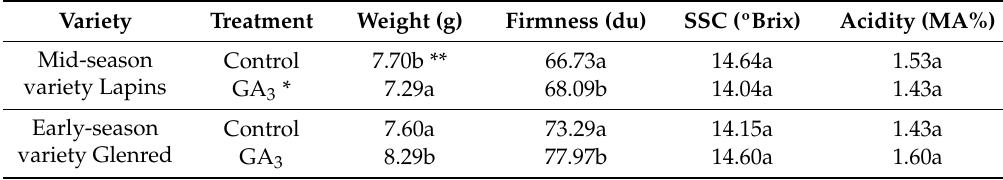
Table 1. Ripening parameters at harvest of mid- and early-season varieties in the 2017–2018 season.